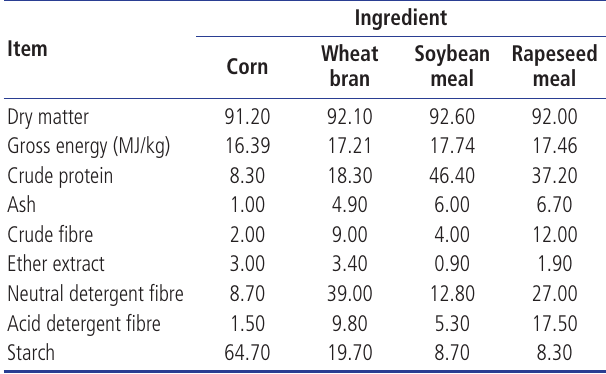
Table 3. Analyzed composition of corn, wheat bran, soybean meal, and rapeseed meal (% as fed basis) 1) Item